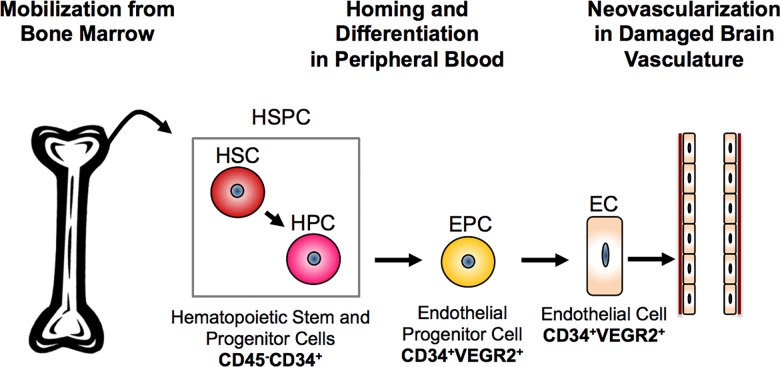
Hematopoietic Stem and Progenitor Cell Populations (HSPC) are vital to vascular endothelial repair and regeneration.HSPC are CD34+ cells derived from the bone marrow, where they reside in the stromal layer until mobilized in response to chemokines and cytokines released from dysfunctional endothelium. In the peripheral blood, they are capable of differentiating into endothelial progenitor cells (EPC) that will home into cites of vascular dysfunction. The EPC retains the hematopoietic surface marker CD34 in addition to gaining the vascular endothelial cell surface marker CD309 or VEGFR2. These cells will differentiate into mature and circulating endothelial cells capable of incorporating into sites of compromised vasculature, and inducing neovascularization as well as proliferation of existing endothelial cells.